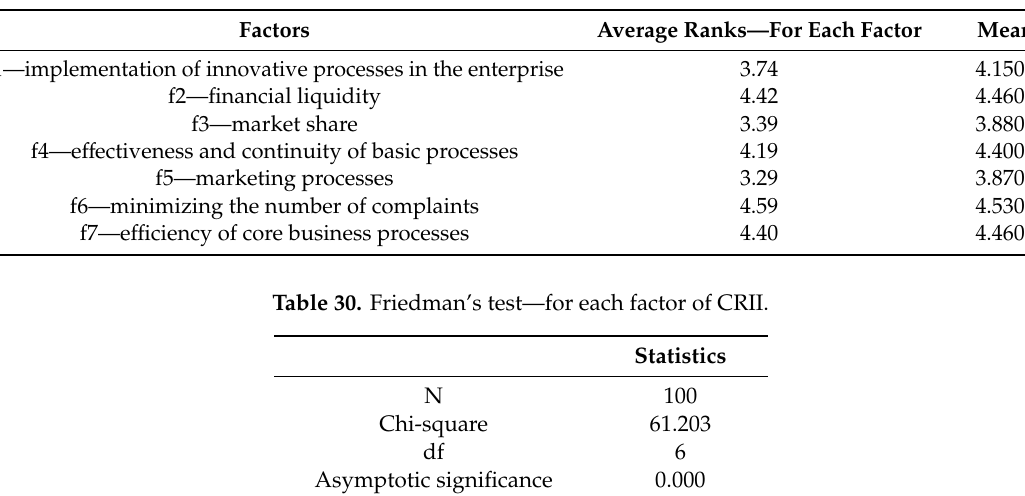
Table 29. Average ranks—for each factor of CRII.